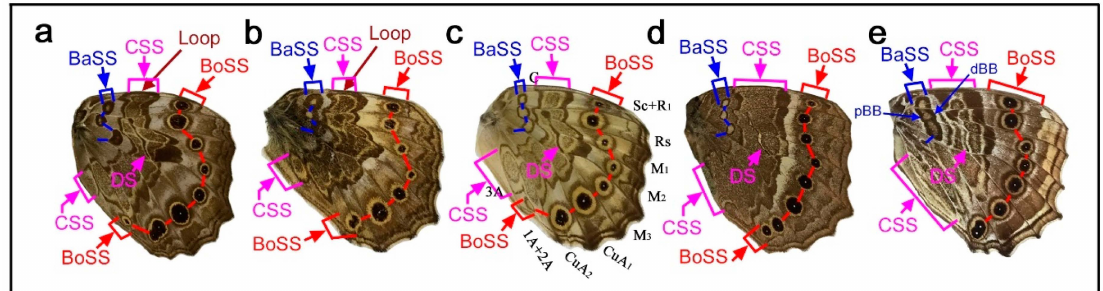
Figure 2. The central and basal symmetry systems (CSS and BaSS) in comparison to the border symmetry system (BoSS) in the genus Neope . Spots of the basal symmetry system are connected with blue lines, and the eyespots (border ocelli) of the border symmetry system are connected with red lines. DS indicates the discal spot. ( a ) Neope bremeri . Anterior connection of the distal and proximal bands of the central symmetry system is indicated as the Loop (also in b). ( b ) Neope niphonica . ( c ) Neope goschkevitschii . The names of the wing compartments are indicated. ( d ) Neope muirheadi . ( e ) Neope yama . The basal symmetry system (BaSS) has the distal and proximal bands (dBB and